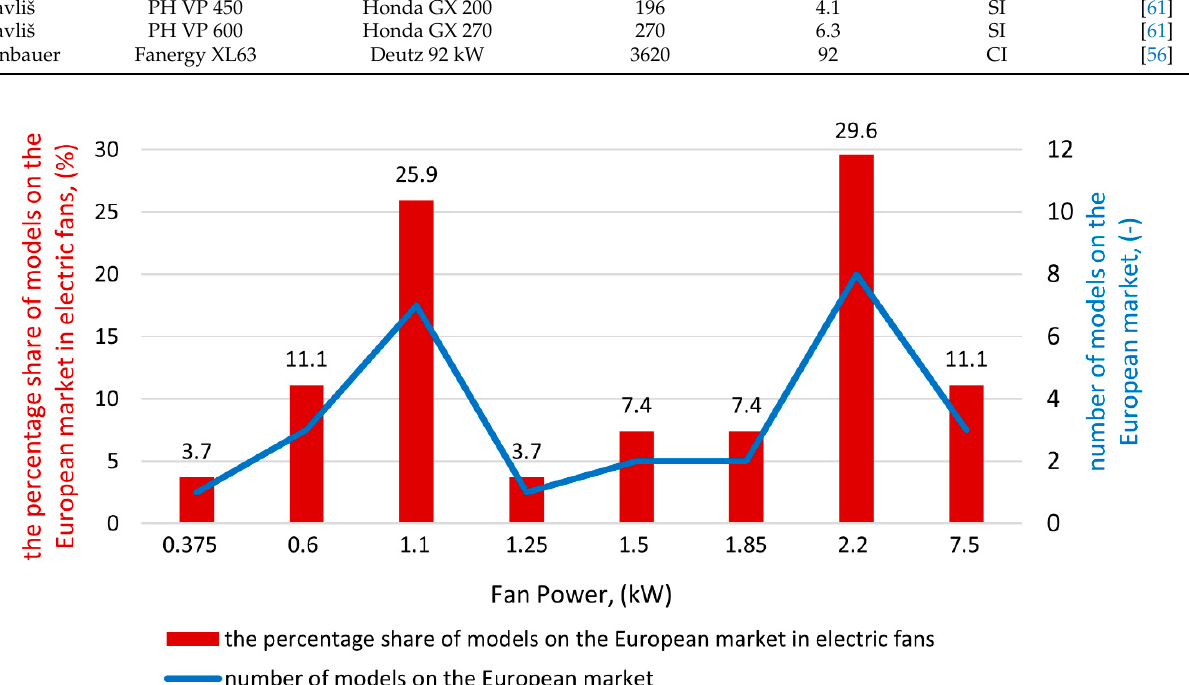
Figure 1. Electric fans on the European market.